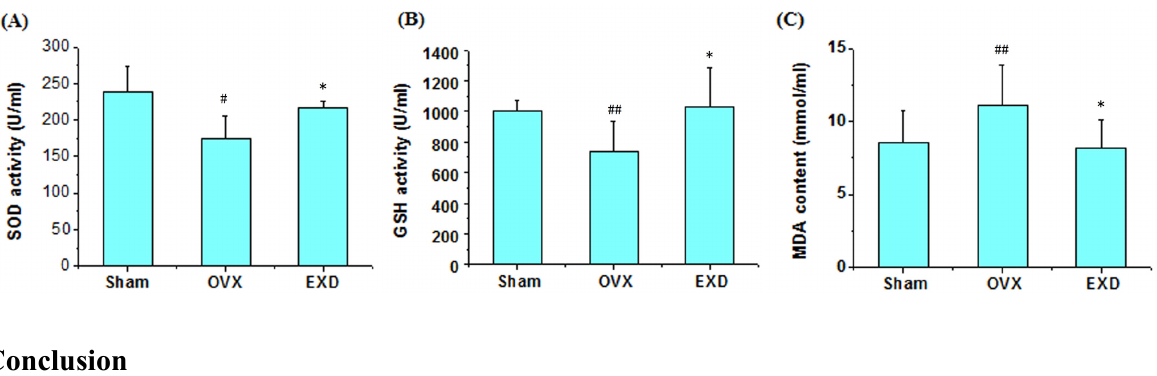
Figure 5. The activity of SOD ( A ), GSH ( B ) and the content of MDA ( C ) in serum of rats of sham, OVX and EXD treatment groups. ## P <0.01, # P < 0.05 compared with sham group; ** P < 0.01, * P < 0.05 compared with OVX